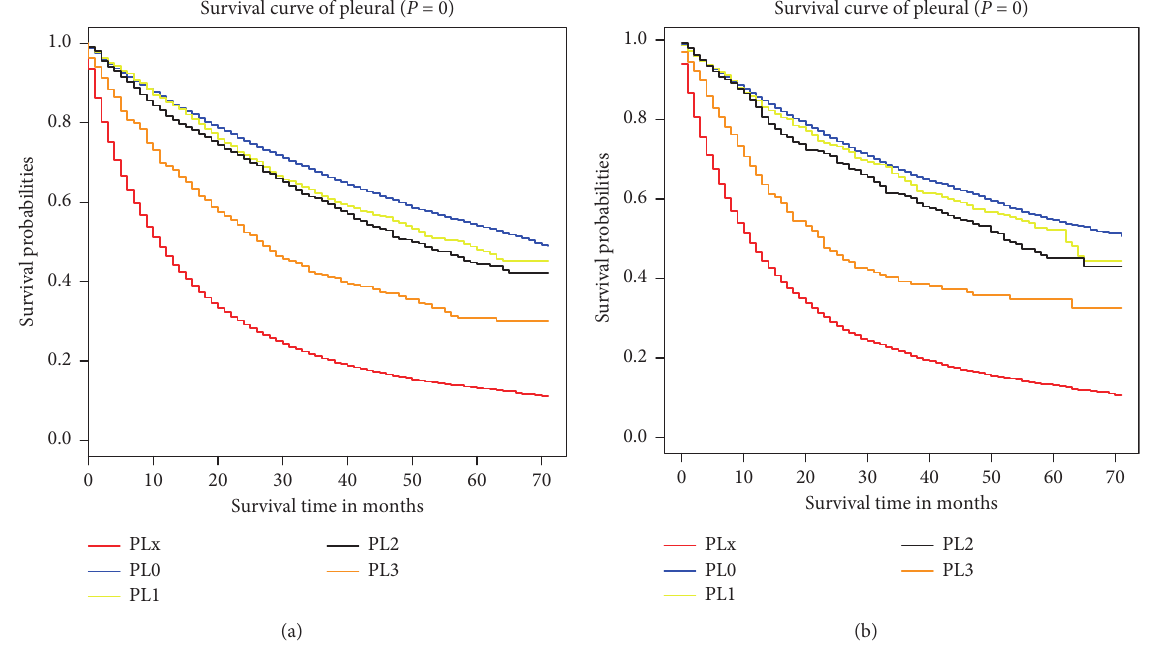
Figure 4: Kaplan–Meier curve analysis in both groups. (a) Risk classification of patient survival with the different degrees of VPI in the training group (log-rank P value for trend < 0.0001). (b) Risk classification of patient survival with the different degrees of VPI in the validation group (log-rank P value for trend < 0.0001). Abbreviation: VPI, visceral pleural invasion.